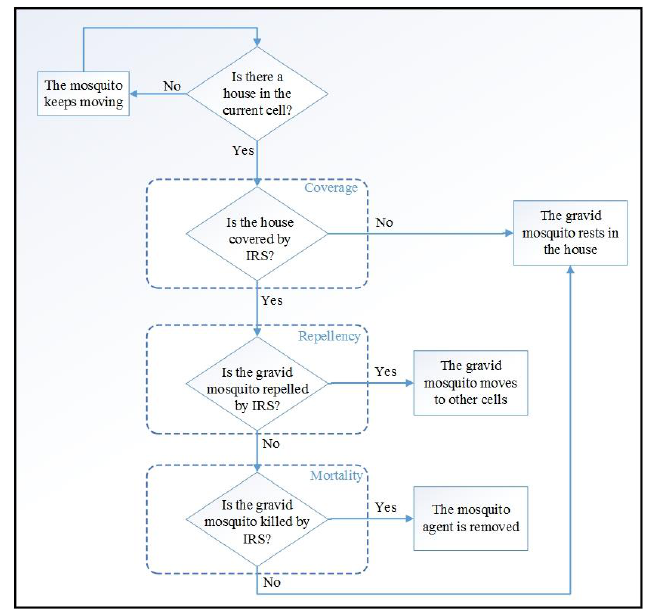
Figure 5. Flowchart of the Indoor Residual Spraying’s (IRS) function.